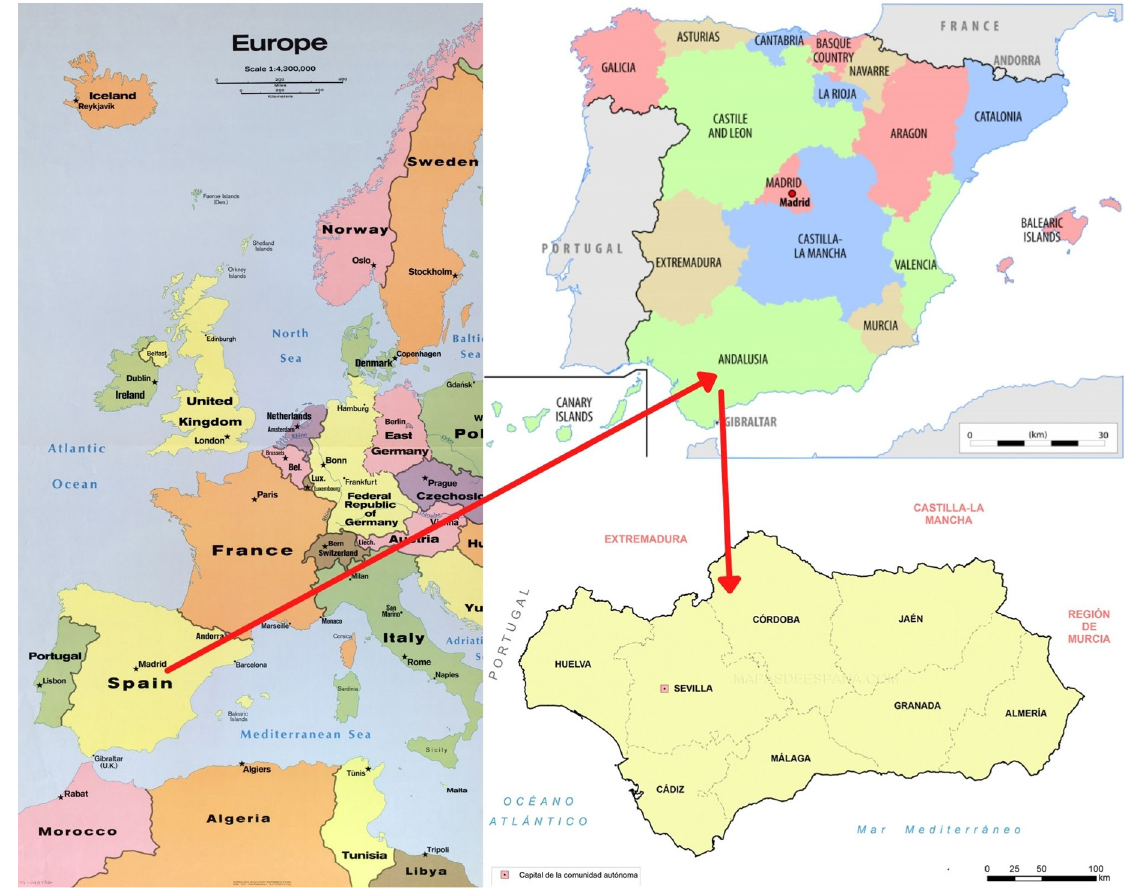
Figure 1. Andalusia map in Europe and